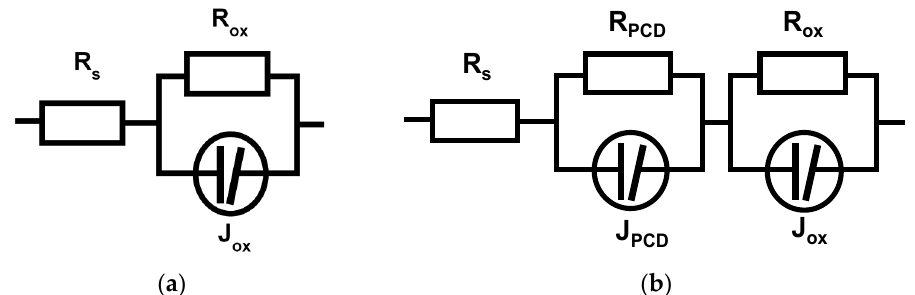
Figure 5. Equivalent circuits used for experimental impedance data fitting: ( a ) uncoated samples before and after exposure to 850 °C steam without diamond layer, and ( b ) diamond-coated samples.